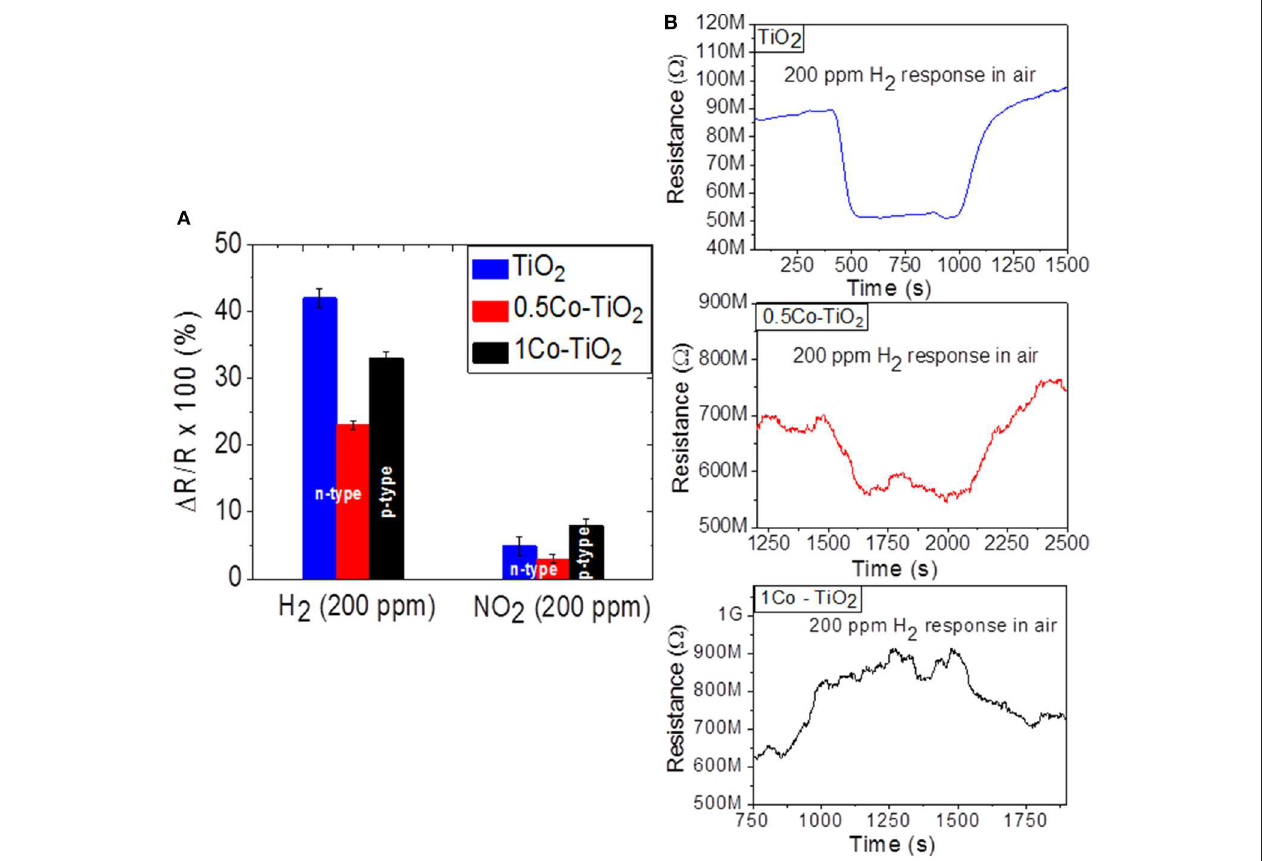
FIGURE 2 | Sensor response of undoped and Co-doped TiO 2 toward (A) NO 2 and H 2 at 600 ◦ C and (B) the relevant dynamic responses toward H 2 .